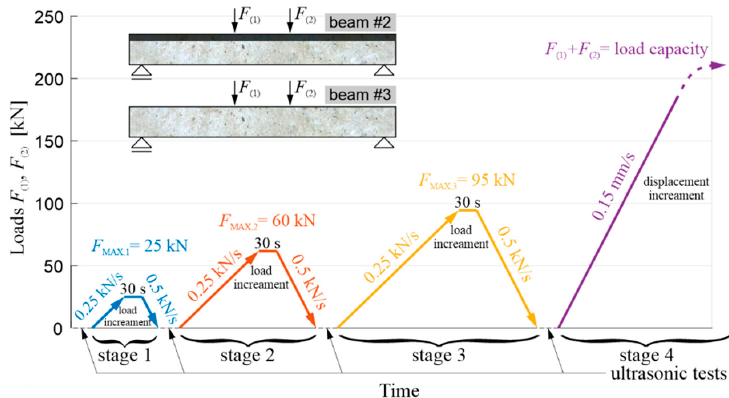
Figure 13. Procedure for the cyclic loading of beams #2 and #3, and ultrasonic testing.